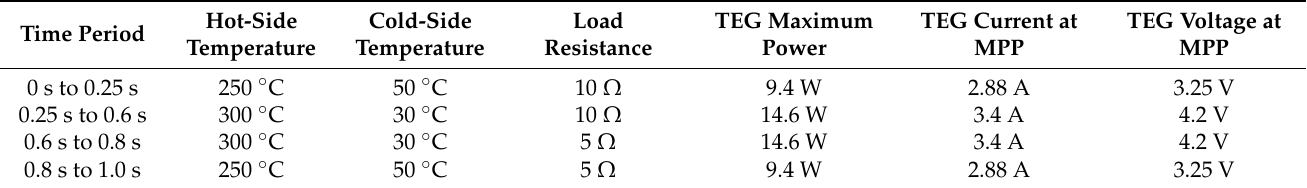
Table 4. Different scenarios